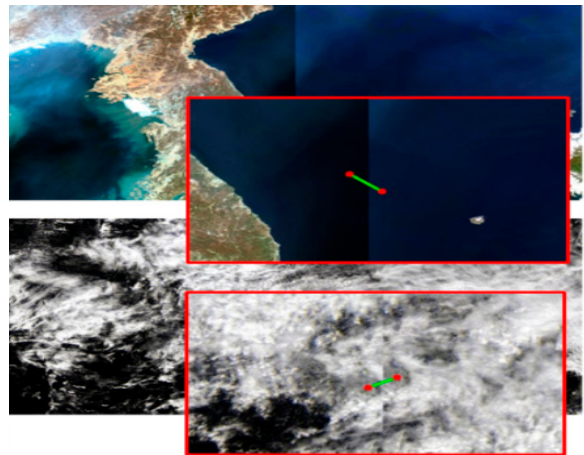
Figure 7. Frequency domain matching result of oceanographic images.